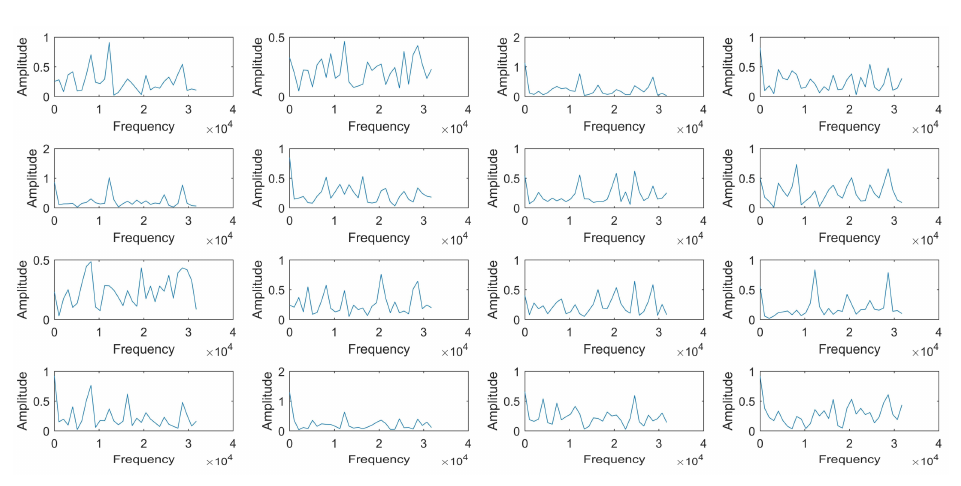
Figure 6. The amplitude spectrum of learned filters in Conv1.